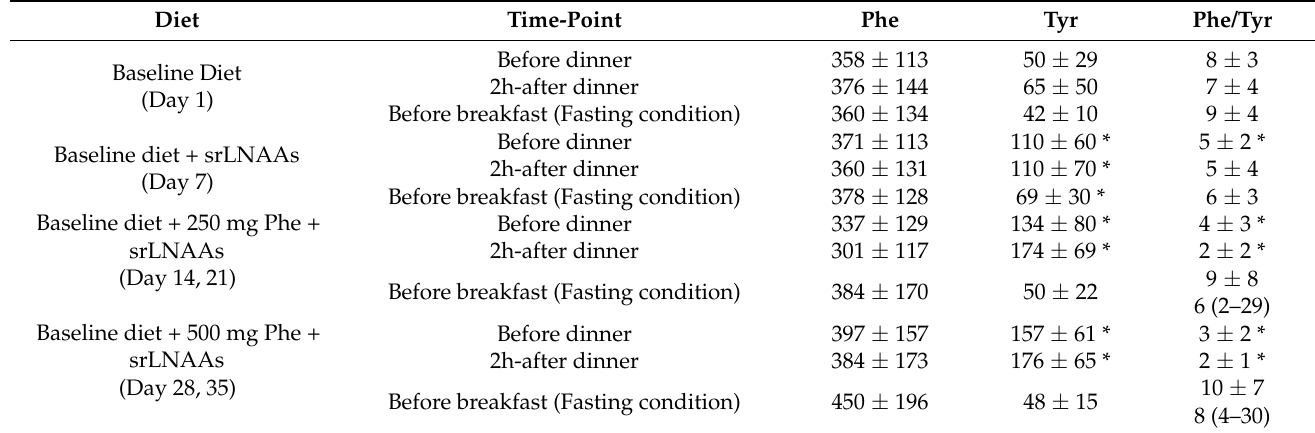
Table 3. Mean values ( ± SD) of plasma Phenylalanine, Tyrosine, and Phenylalanine/Tyrosine